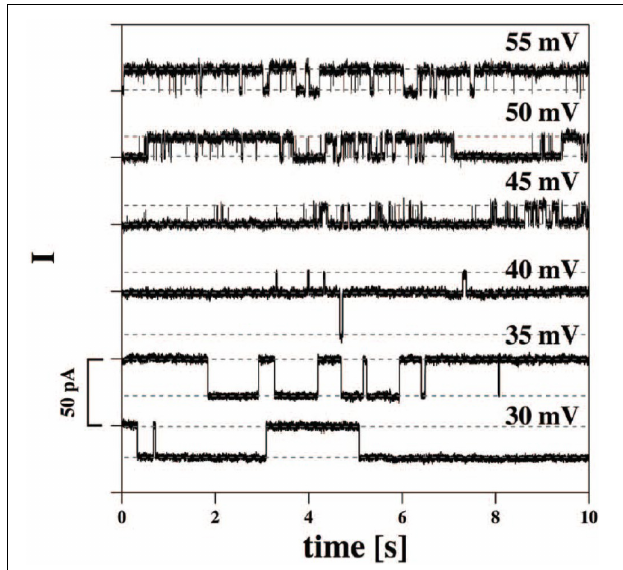
FIGURE 1 | Current traces from synthetic bilayer membranes in the absence of proteins. From Blicher and Heimburg (2013).